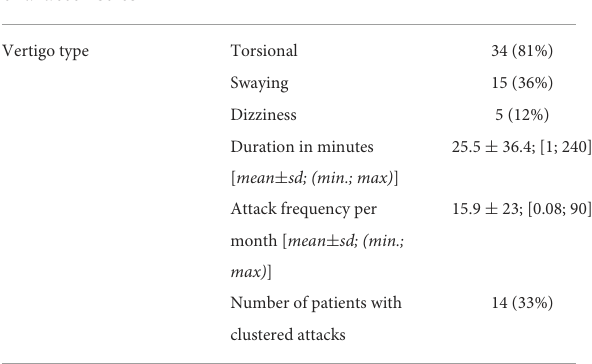
TABLE 1 Characteristics of vertigo/imbalance attacks in 42 children with Recurrent Vertigo of Childhood. Attack